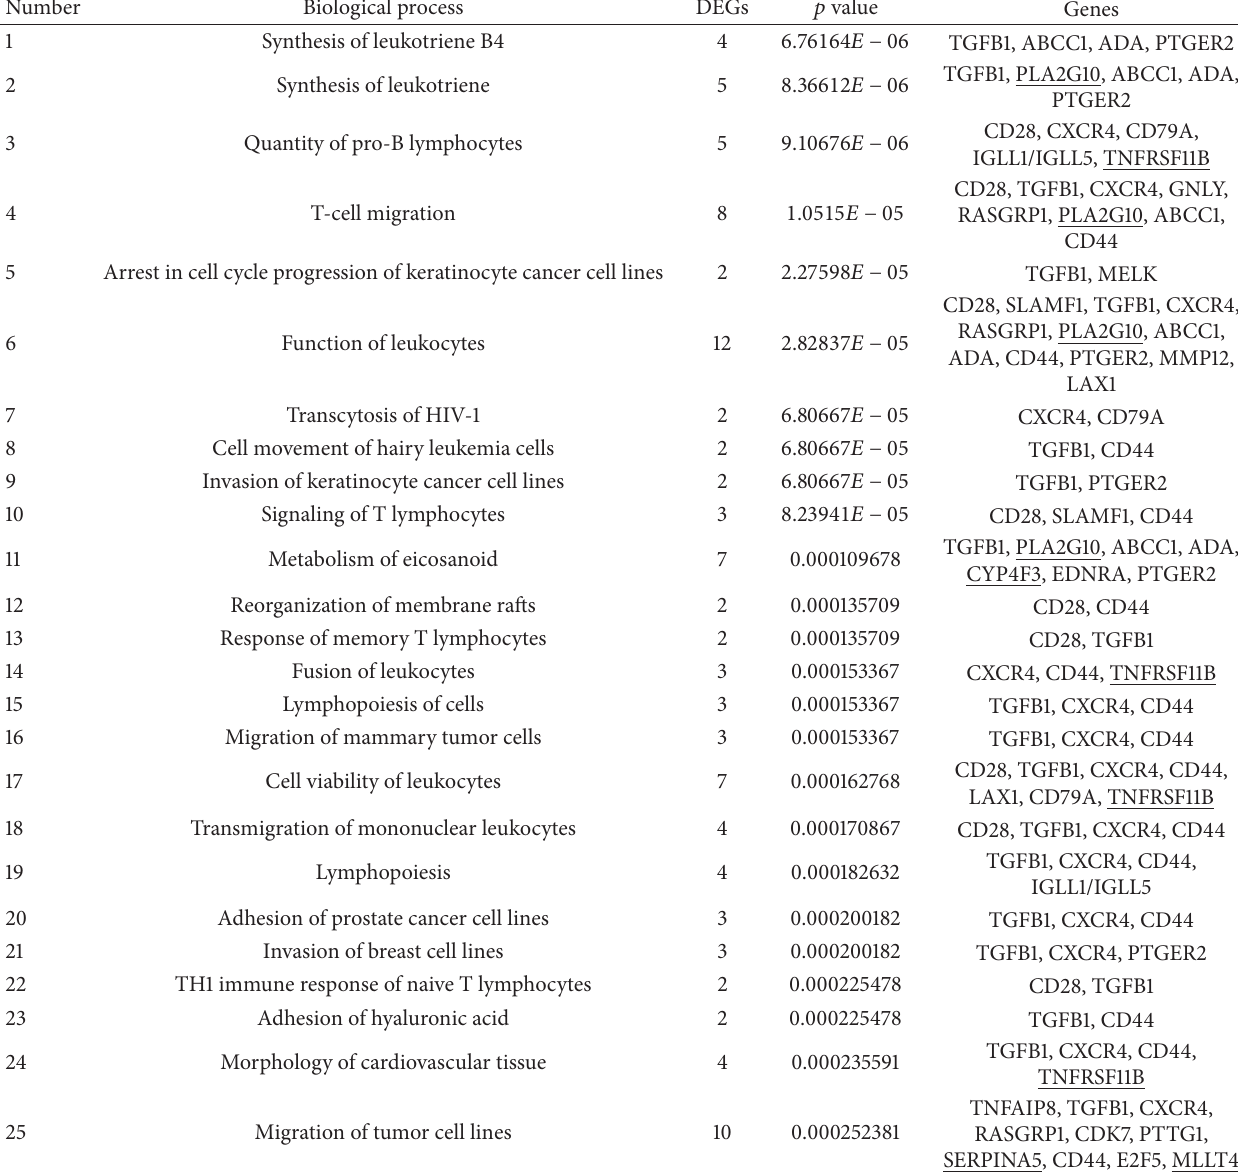
Table 3: Top 25 biological processes associated with IPH in Ingenuity